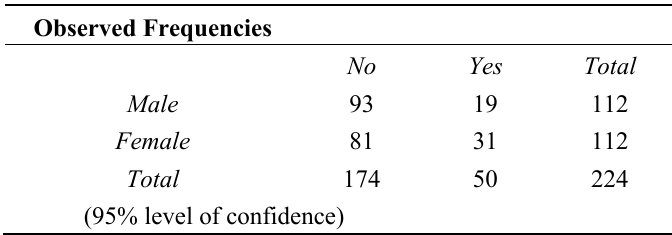
Table 1. Cross tabulation analysis between gender and anger.